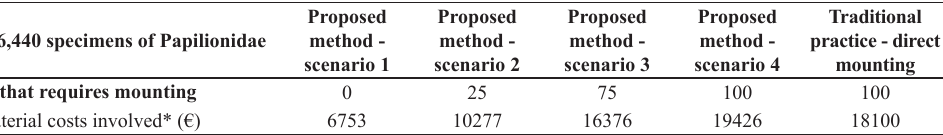
Table 3. Costs required to handle and digitize 16,440 specimens of Papilionidae in four scenarios, compared to the traditional practice of mounting. Scenario 1 corresponds with the results of the 2016